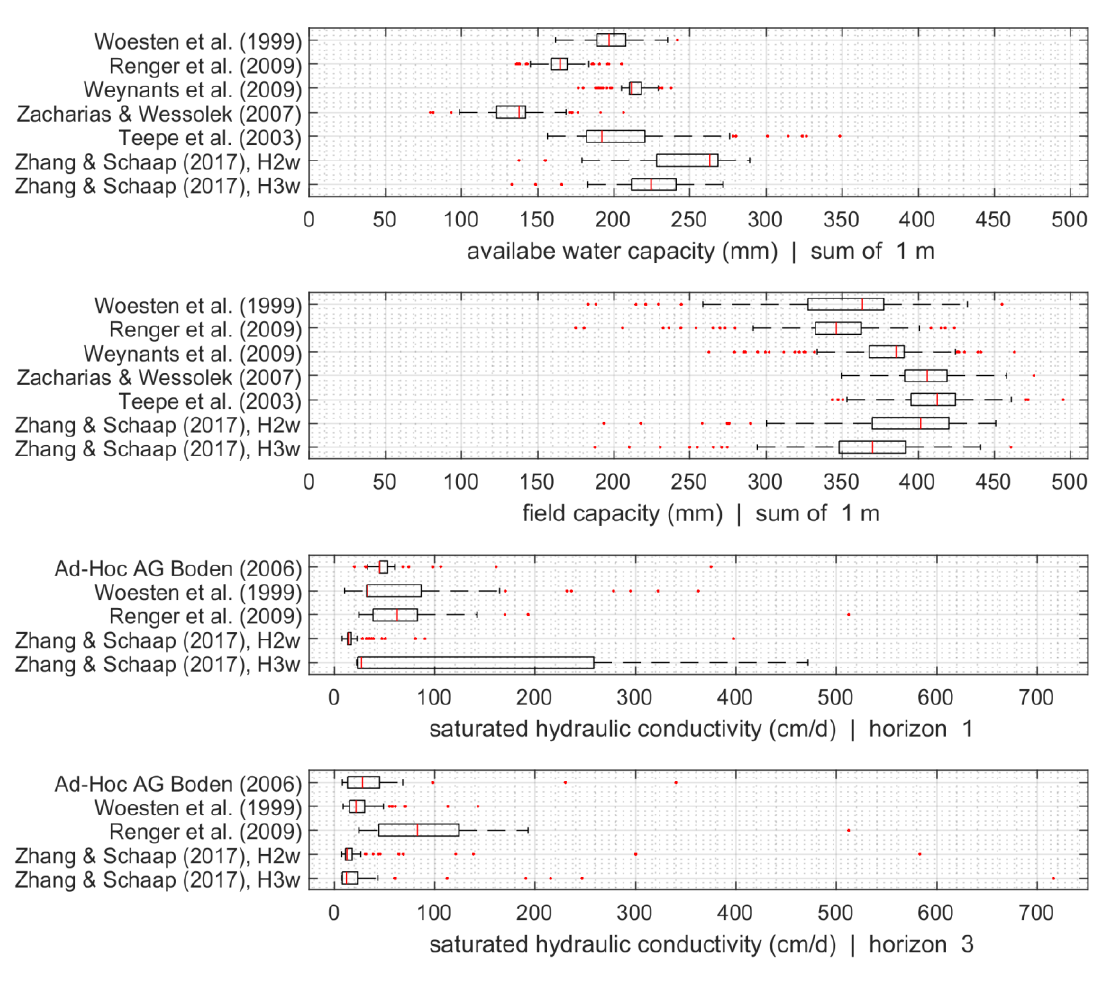
Figure 2. Distribution of the soil hydraulic properties AWC, FC, and K sat for the land use types cropland, grassland and Forest in the Glonn catchment.